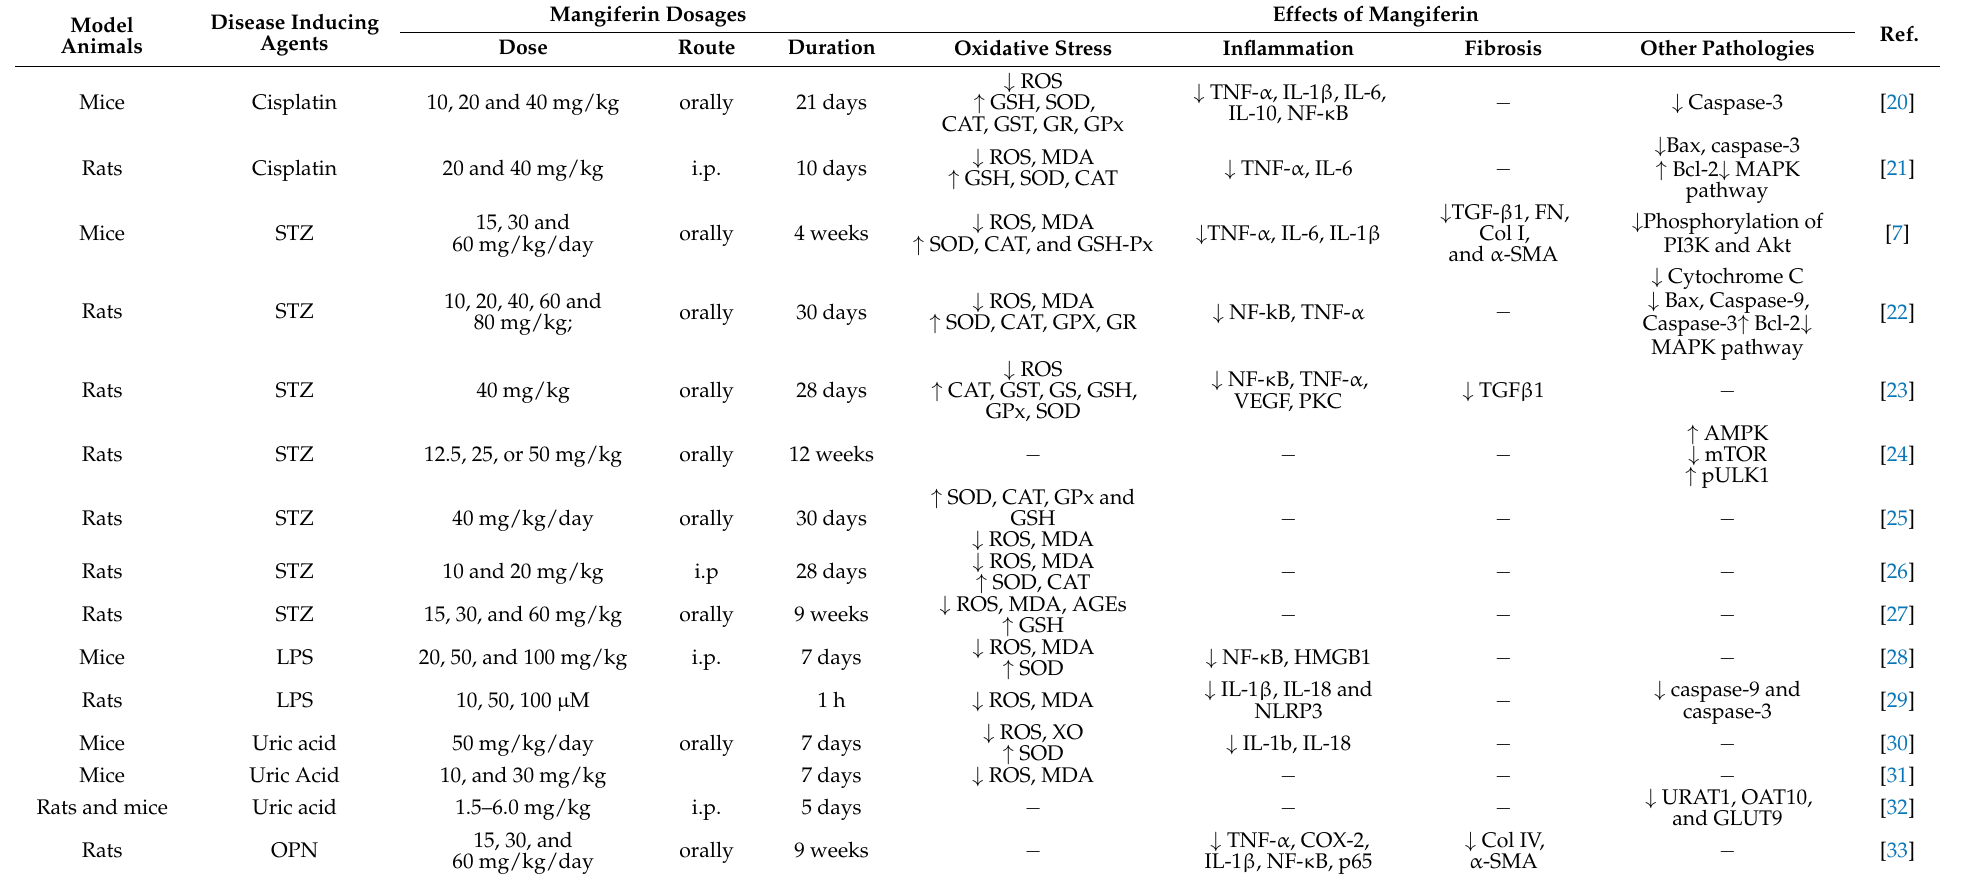
Table 1. In vivo renoprotective effects of